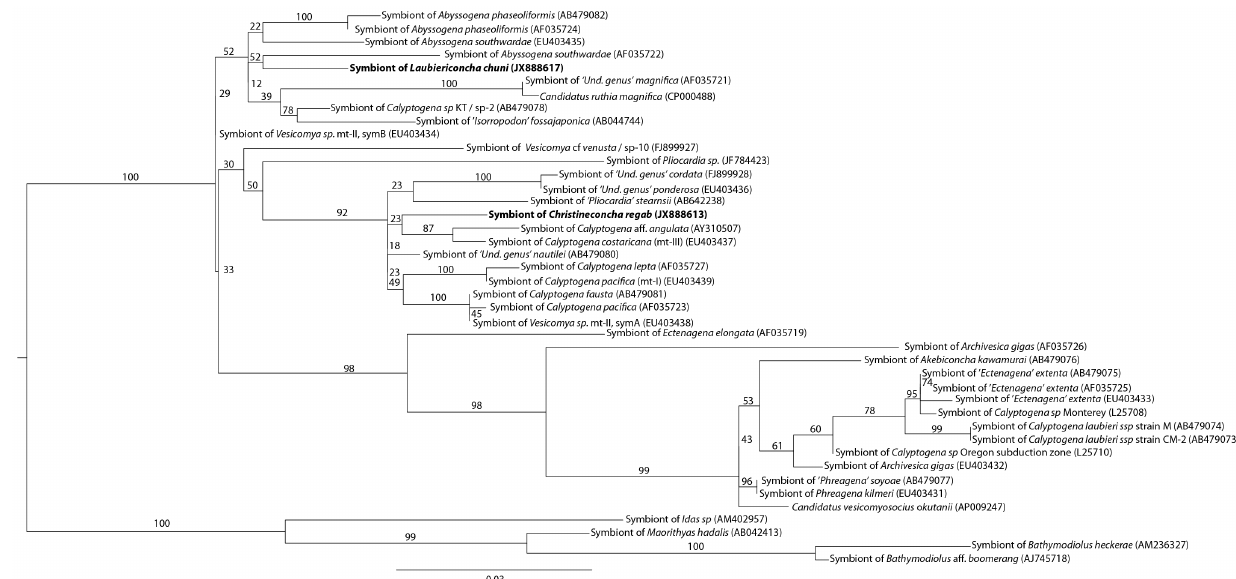
Figure 3. 16S rRNA maximum-likelihood tree. The evolutionary model tested was GTR + I + G (proportion of invariable sites=0.66, number of substitution rates=6, gamma distribution parameter=0.64). Bootstrap values for 1000 replicates are given in percent above branches and clades. Scale bars are expressed as number of substitutions per base pair. ‘Und. genus’) indicates a temporary genus name. Sp-1 to 9 correspond to species numbers given in Audzijonyte et al. 2012.